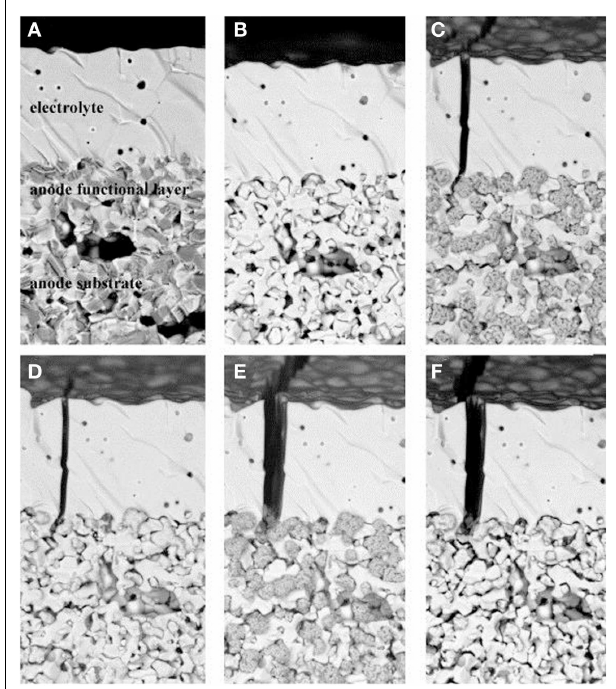
FIGURE 1 | SEM study of microstructural changes in anode and anode substrate due to reduction/re-oxidation cycles . (A) Initial as co-fired state, (B) reduced, (C) re-oxidized, (D) re-reduced, (E) re-re-oxidized, (F) re-re-reduced with additional holding time of 100h (Malzbender and Steinbrech, 2007). Reprinted with permission from